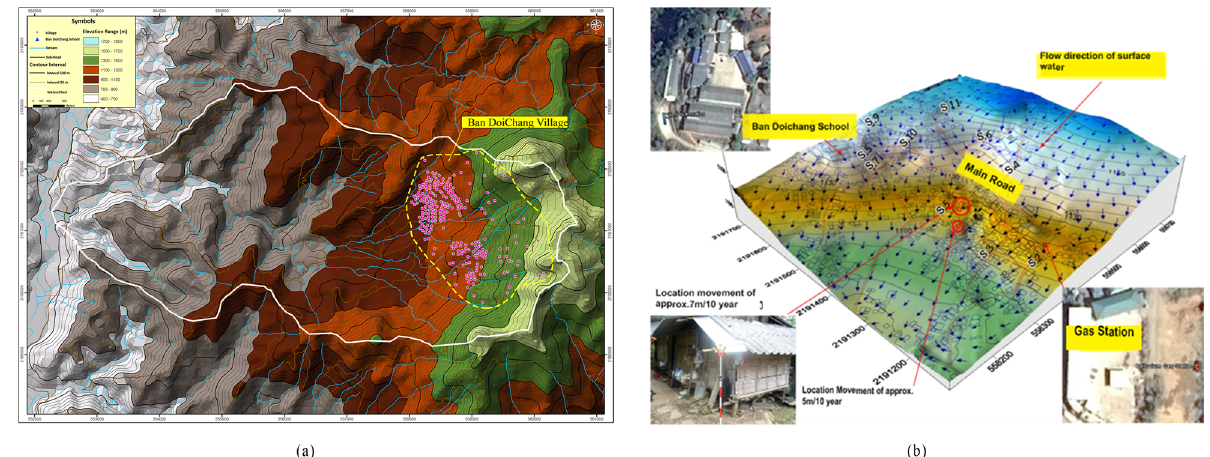
Figure. 1. ( a ) Contour map of the study area along with settlements ( b ) 3D topography showing the direction of flow of surface